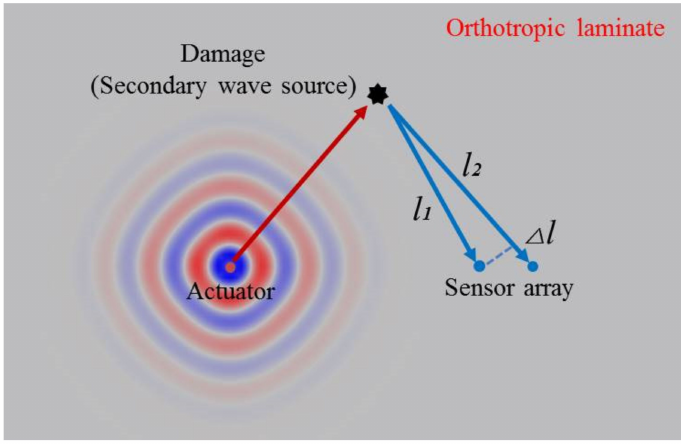
Figure 1. Schematic diagram of the